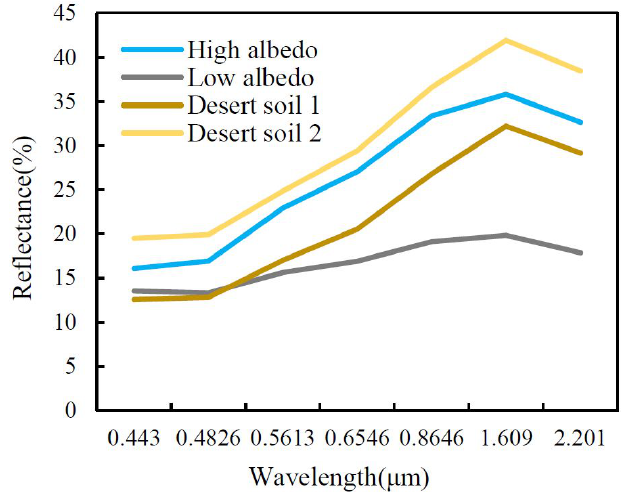
Figure 2. Spectral curves of impervious surfaces and desert soil in Yinchuan. The image was taken on 1 September 2015. High and low albedo are the main types of impervious surfaces. Desert soils 1 and 2 represent the two main soil